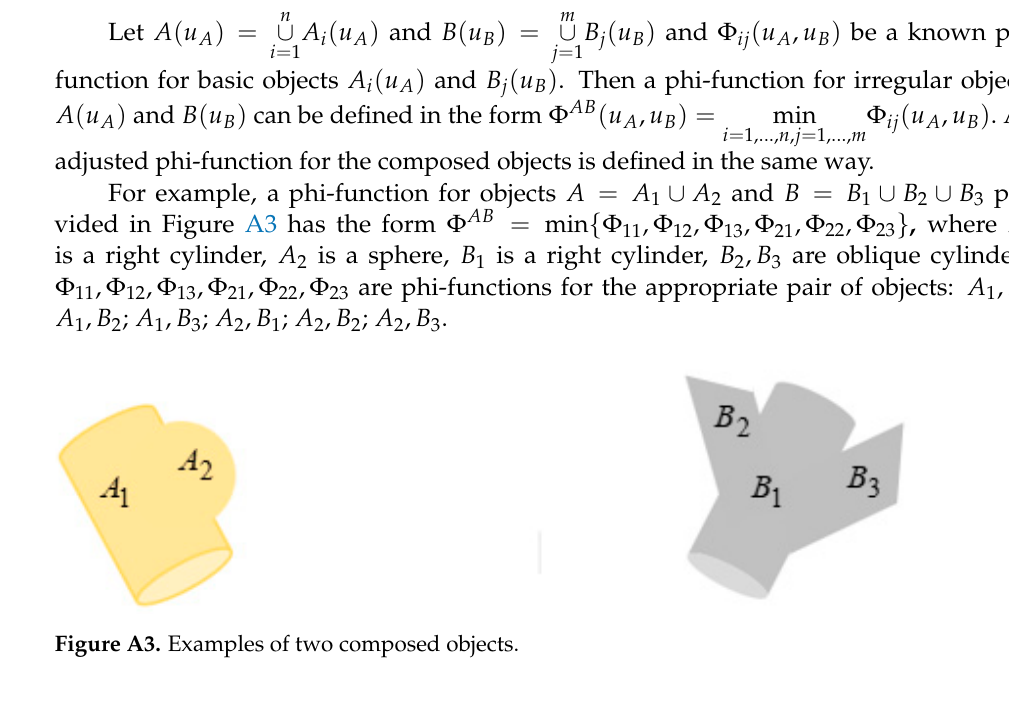
Figure A3. Examples of two composed objects.